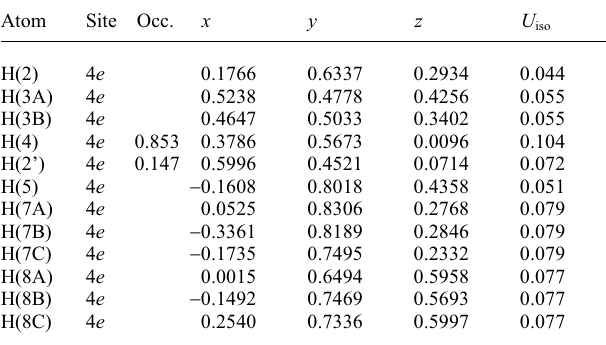
Table 2. Atomic coordinates and displacement parameters (in Å 2 )